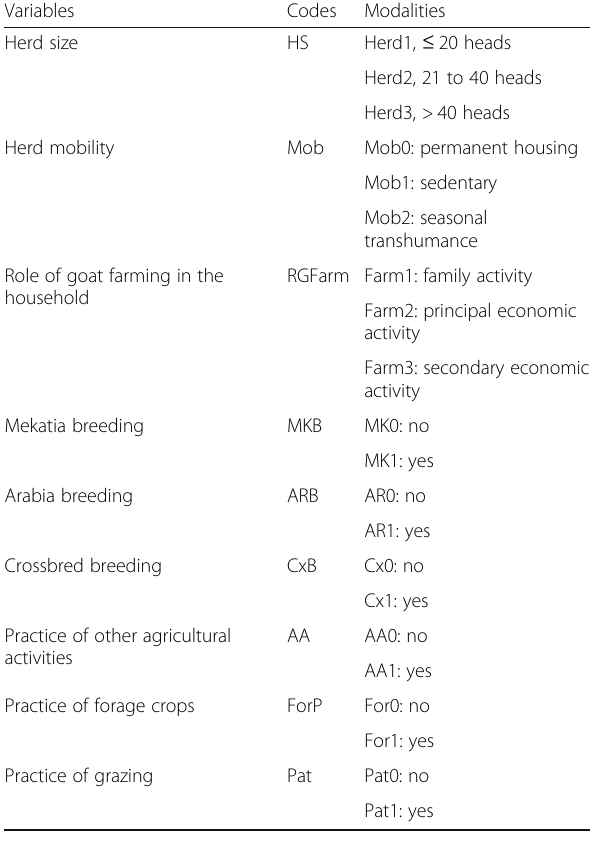
Table 1 Codes for variables and modalities included in the multiple correspondence analysis